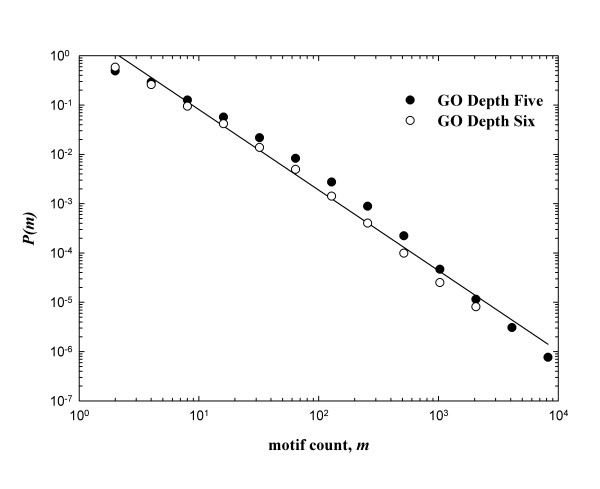
Distribution of motif counts for motif modes in the yeast PPI network. Distribution of motif counts (logarithmic binning) for motif modes shown on a log-log plot are marked as filled and open circles when the GO terms at depths five and six were employed, respectively. The solid line indicates a fit to P(m)~m-φ where m is the motif count and φ is the degree exponent ~1.6.